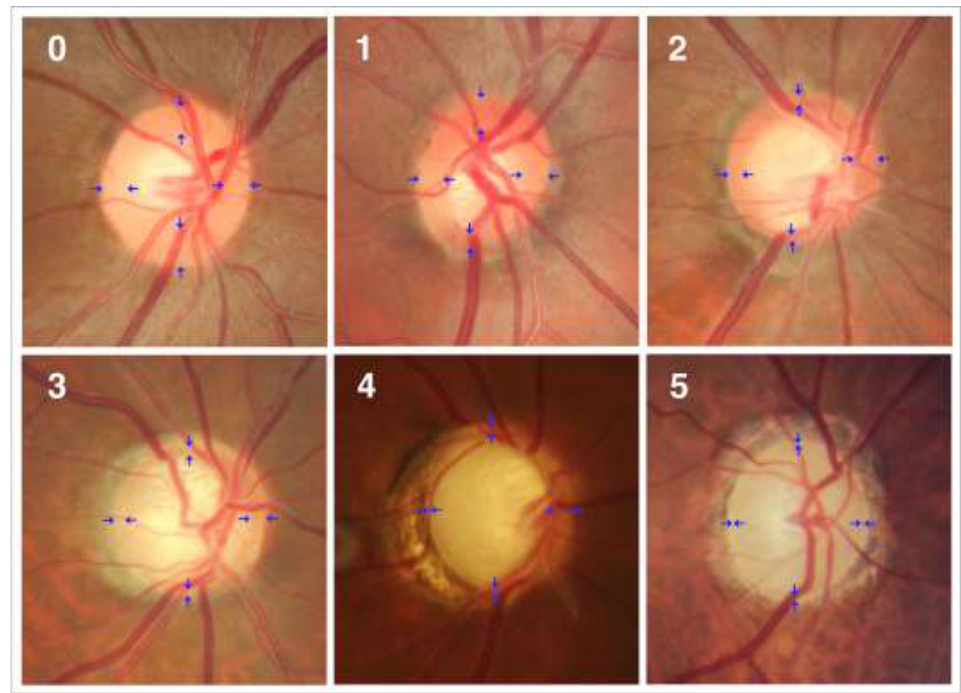
Figure 2. Photographs of the optic disc showing a normal disc (0) and optics with varying degrees of glaucomatous optic nerve damage (Stages 1–5). These phases are classified based on the shape of the neuroretinal rim (blue arrow) [8].